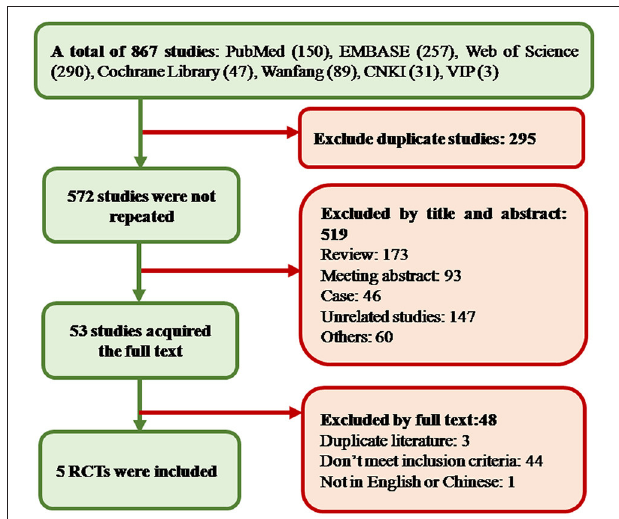
FIGURE 1 | Study screening diagram. In the process of screening and selection, a total of 867 studies were obtained. Finally, five studies were included. CNKI, China National Knowledge Infrastructure; RCT, randomized controlled trial.